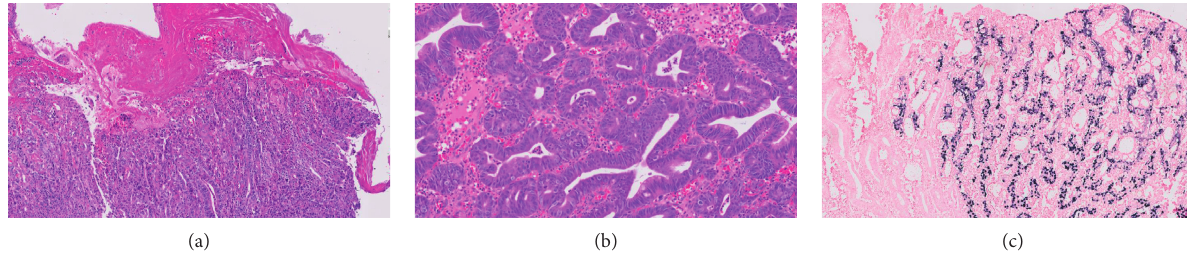
Figure 2: (a) 10x magnification of histopathology of the polypoid gastric body lesion showing poorly differentiated adenocarcinoma with surface ulceration. (b) High-power magnification of the gastric polypoid lesion showing high-grade dysplasia. (c) EBV-infected carcinoma cells (black stain present) juxtaposed with normal gastric glandular mucosa (black stain absent), using EBV-related encoded RNA in situ hybridization assay (EBER